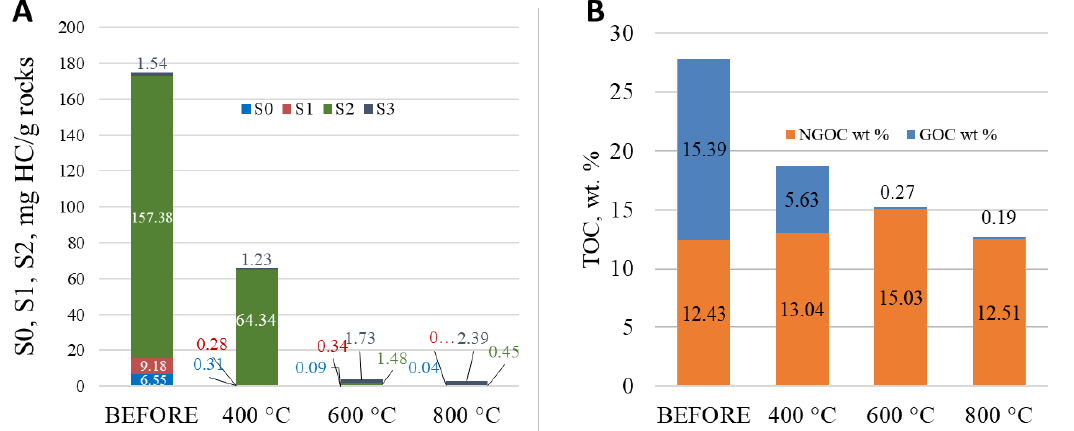
Figure 9. ( A ) Free (S0), adsorbed (S1), and generated (S2) hydrocarbon amount, and CO 2 (S3) change; ( B ) total organic carbon alteration after heating up to 800 °C. GOC — generative organic carbons, NGOC — nongenerative organic carbon.